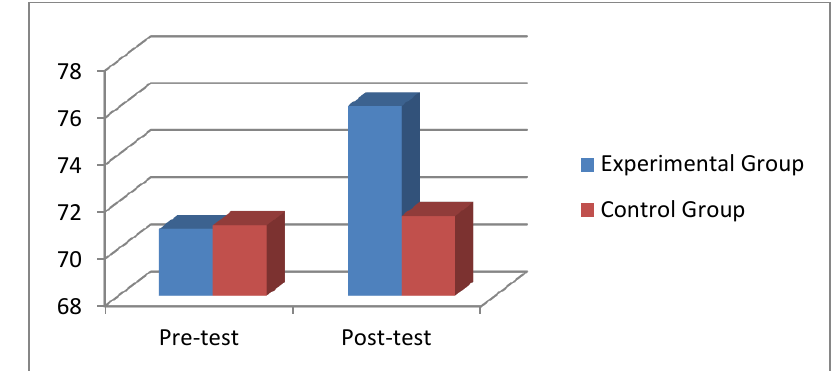
Figure 1. The Comparison Post-test Mean Score of Experimental and Control Group